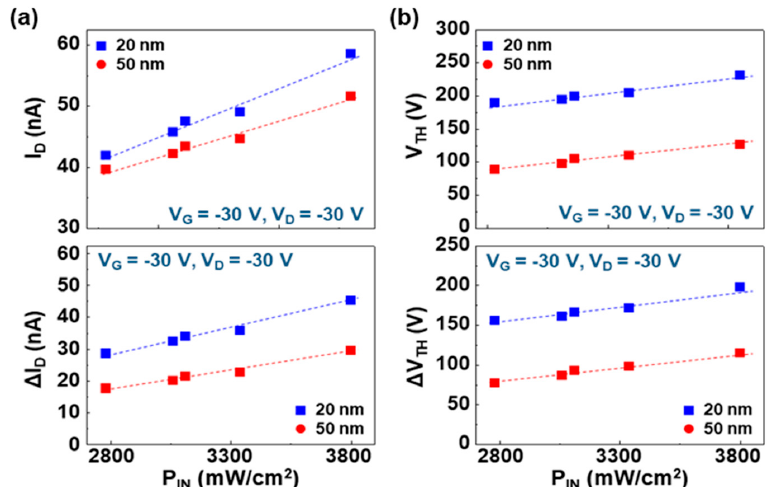
Figure 6. Variation of sensing parameters (taken from the transfer curves in Figure 5) as a function of the incident high-power NIR light intensity (P IN = 2.8~3.8 mW/cm 2 ): ( a ) drain current (I D ) and net drain current ( Δ I D ), ( b ) threshold voltage (V TH ) and threshold voltage shift ( Δ V TH ). The slope ( Δ V TH /P IN ) was 4.11 × 10 4 V · cm 2 /W (t = 20 nm) and 3.7 × 10 4 V · cm 2 /W (t = 50 nm).